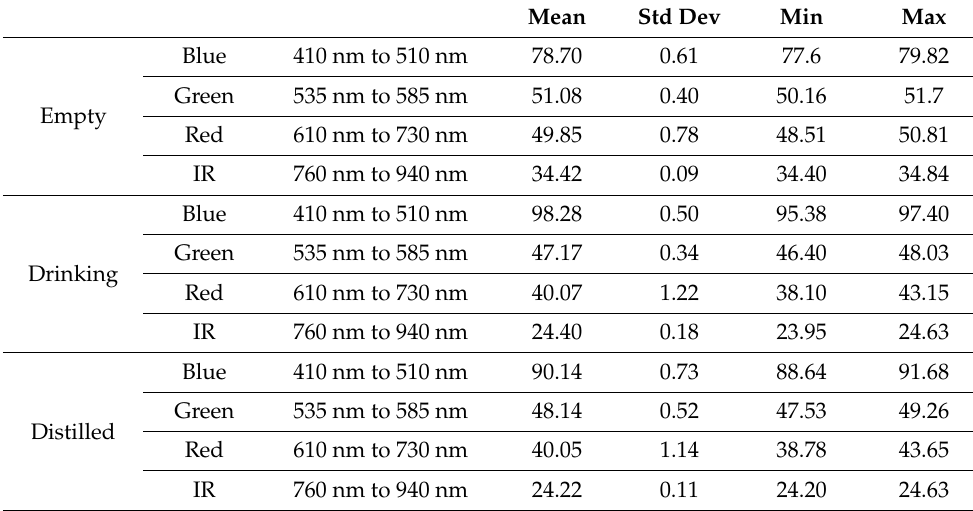
Table 2. Comparison of descriptive statistics of the raw spectral intensity readings grouped by color. Three conditions were examined: an empty beaker, 500 mL of drinking water, and 500 mL of distilled water.